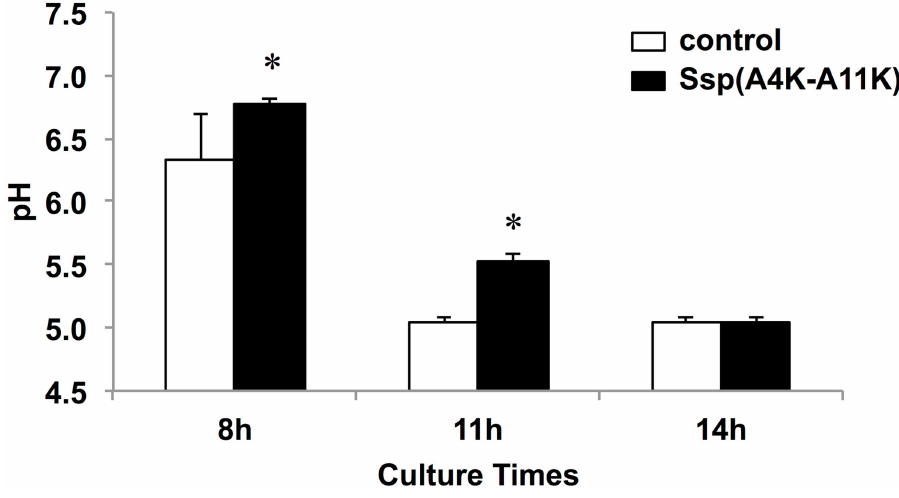
Fig 6. pH of culture media according to the time of biofilm formation. The pH of spent culture media was measuredusing a standardpH electrode. Data are expressedas the means ± SDs of three independent experiments with technicalreplicates(vs. control: non-treateds-PS; * P < 0.05).